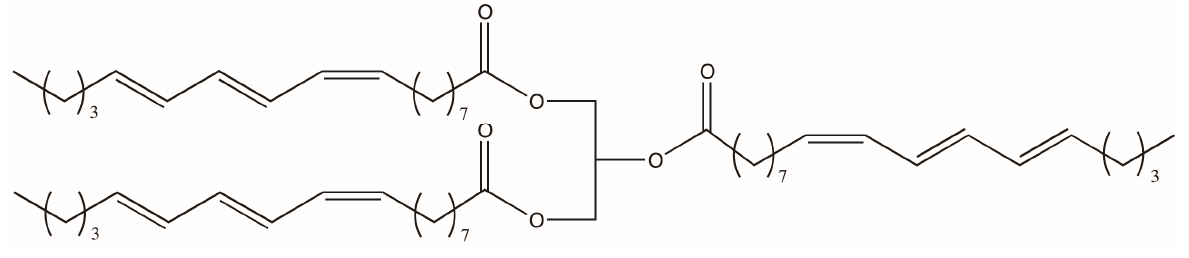
Figure 1. Chemical structure of tung